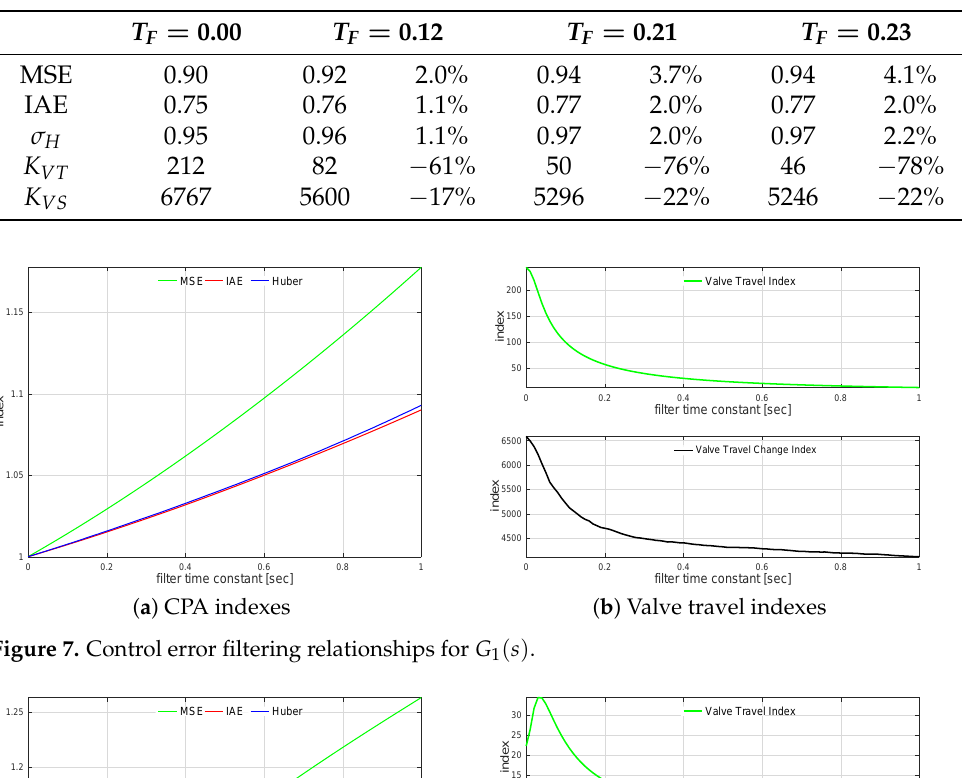
Table 17. Control error filter impact on G 4 ( s ) .